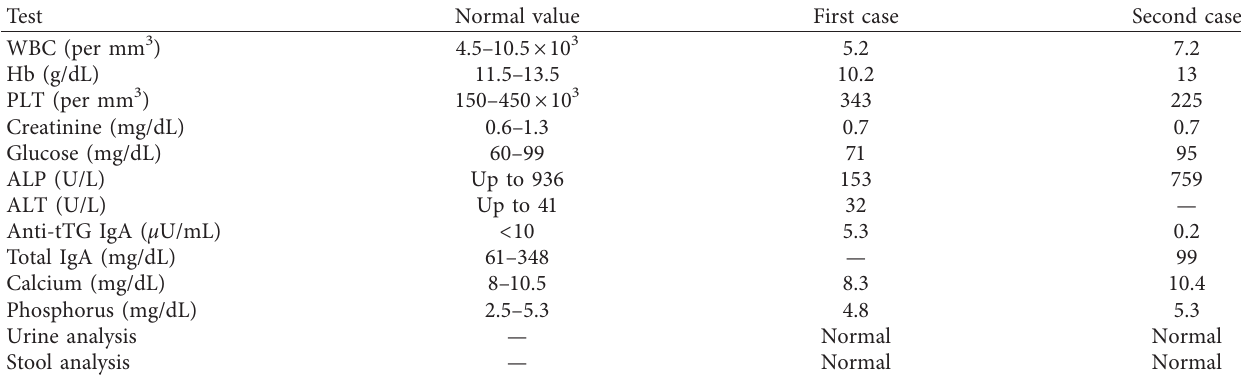
Table 1: Results of the complete blood count and basic metabolic panel for both patients.